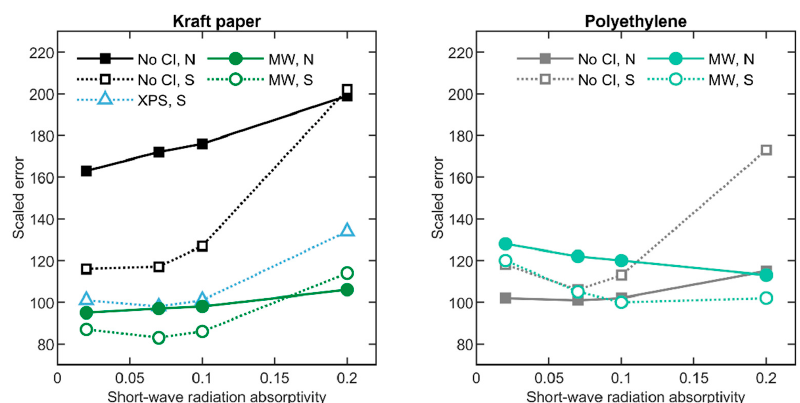
Figure 21. Scaled error for vinyl siding short-wave absorptivity. Left subfigure plots kraft walls while right subfigure plots poly walls.